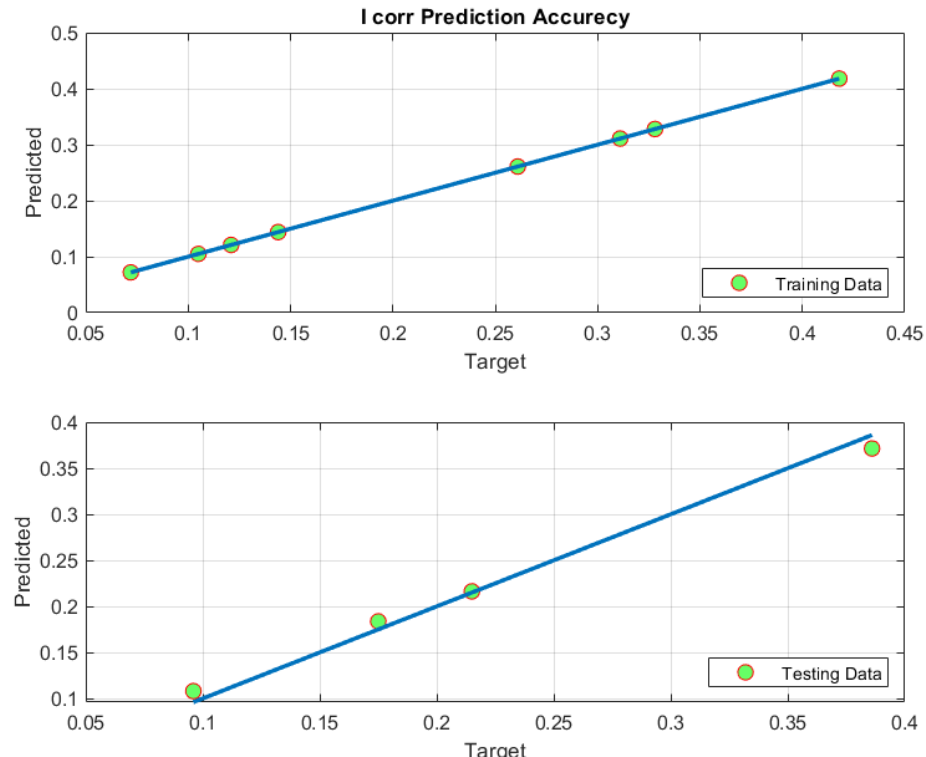
Figure 7. The prediction precision of the ANFIS-based model.